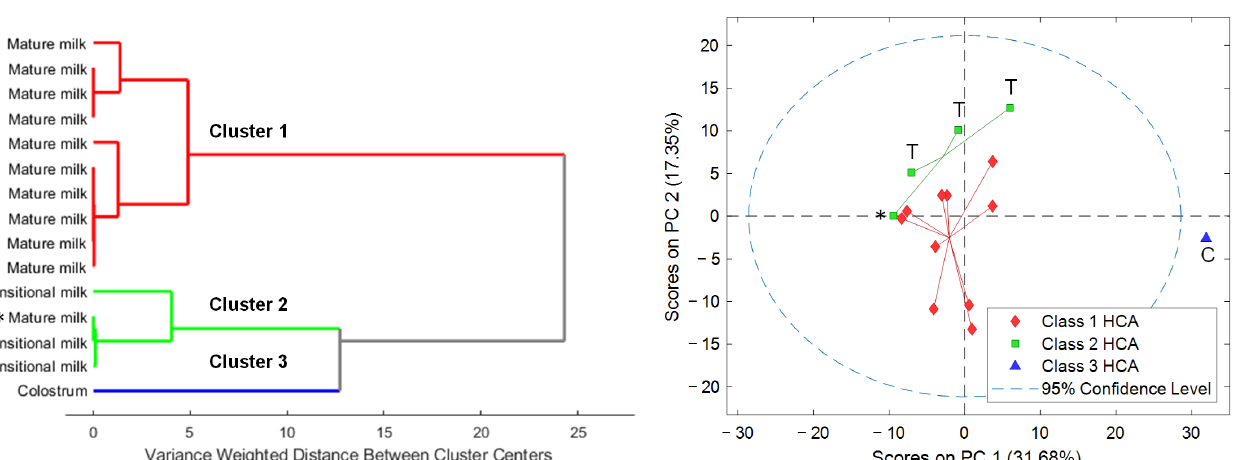
Figure 2. Evolution of the Simpson Index of Diversity of HM cells as a function of the postnatal age. HCA revealed three distinct clusters based on the number and proportion of the different cell types detected in HM samples (see Figure 3, left). Cluster 3 separated, as expected, the colostrum sample from the remaining samples according to the clear differences in total cell count and cell type composition in comparison to transitional and mature HM samples. On the other hand, cluster 2 included transitional milk samples and one mature milk sample, and cluster 1 gathered exclusively mature milk samples.